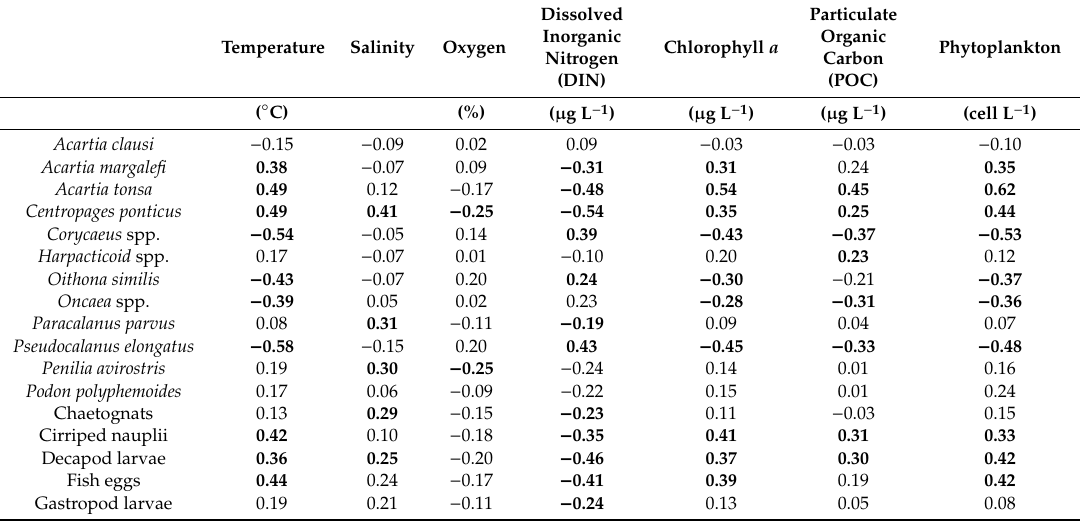
Table 4. Results of the Kendall rank correlation test at seven stations for the 2003–2004 period. Statistically significant values are marked in